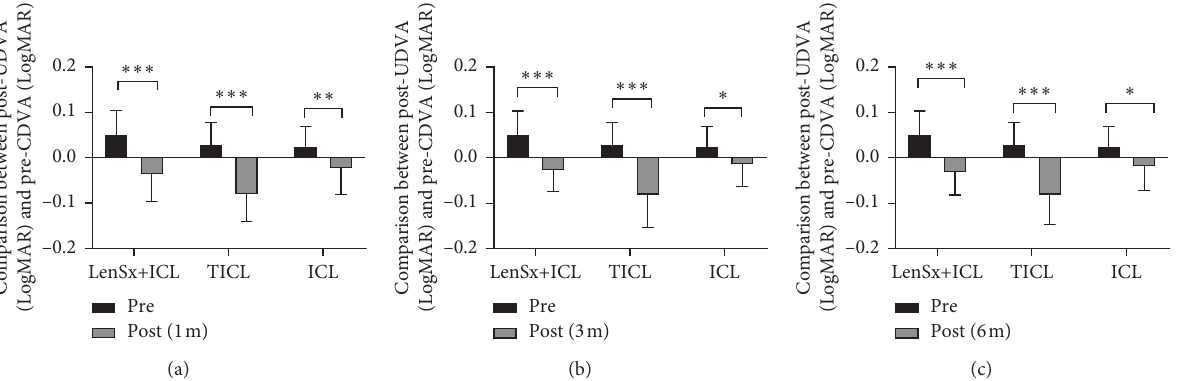
Figure 3: The postoperative LogMAR UDVA and preoperative LogMAR CDVA in three groups after surgery at 1, 3, and 6 months (the results are expressed as means ± SD, ∗ means P < 0 . 05, and ∗∗∗ means P < 0 . 001). (a) Comparision between post-UDVA (LogMAR) and pre- CDVA (LogMAR). (b) Comparision between post-UDVA (LogMAR) and pre-CDVA (LogMAR). (c) Comparision between post-UDVA (LogMAR) and pre-CDVA (LogMAR).